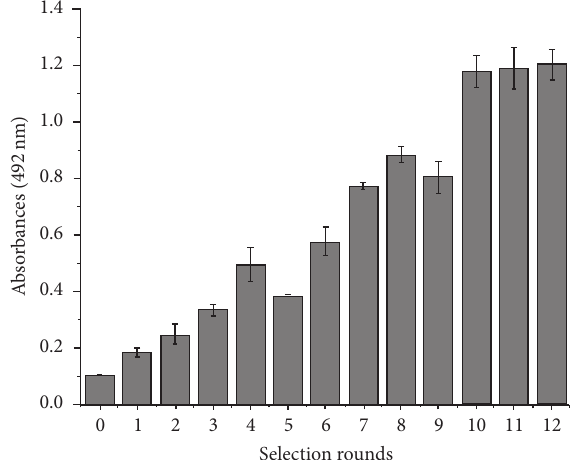
Figure 2: Binding of the ssDNA library to BTX-2-BSA during the 12 SELEX